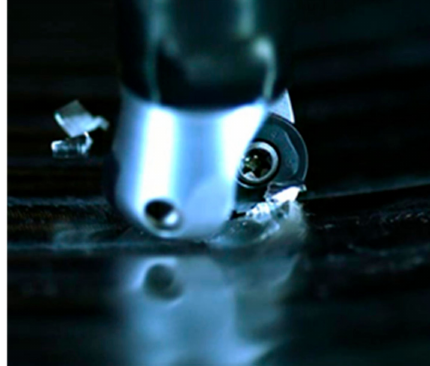
Figure 4. Image obtained from the video by a high-speed camera, during the experimental